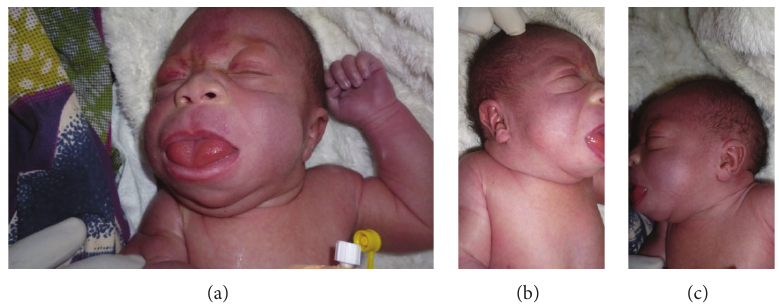
Figure 1: Facial signs: note (a) macroglossia and nevus flammeus on the face; (b) crumped helix on her right ear; (c) ear crease on the left lobe.